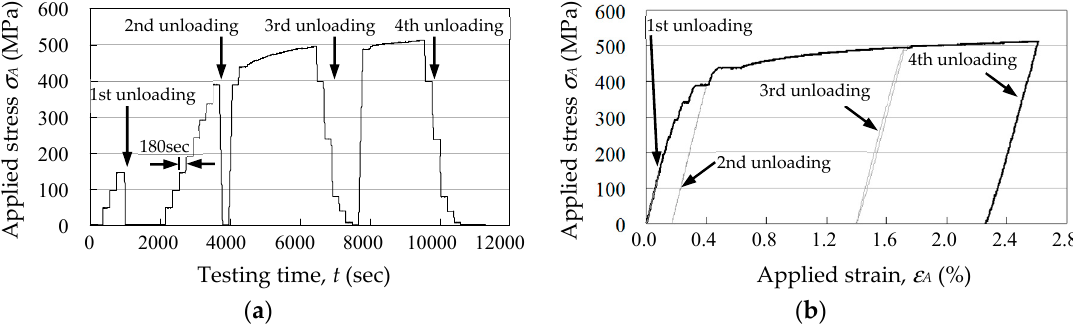
Figure 6. Setup image and optical system of in-situ neutron diffraction measurement during tensile test. ( a ) Side view, ( b ) Top view [14].